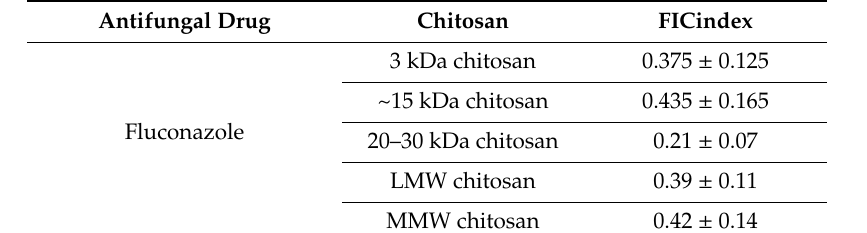
Table 4. Checkerboard assays of each chitosan in combination with fluconazole against C. tropicalis MYA3404.